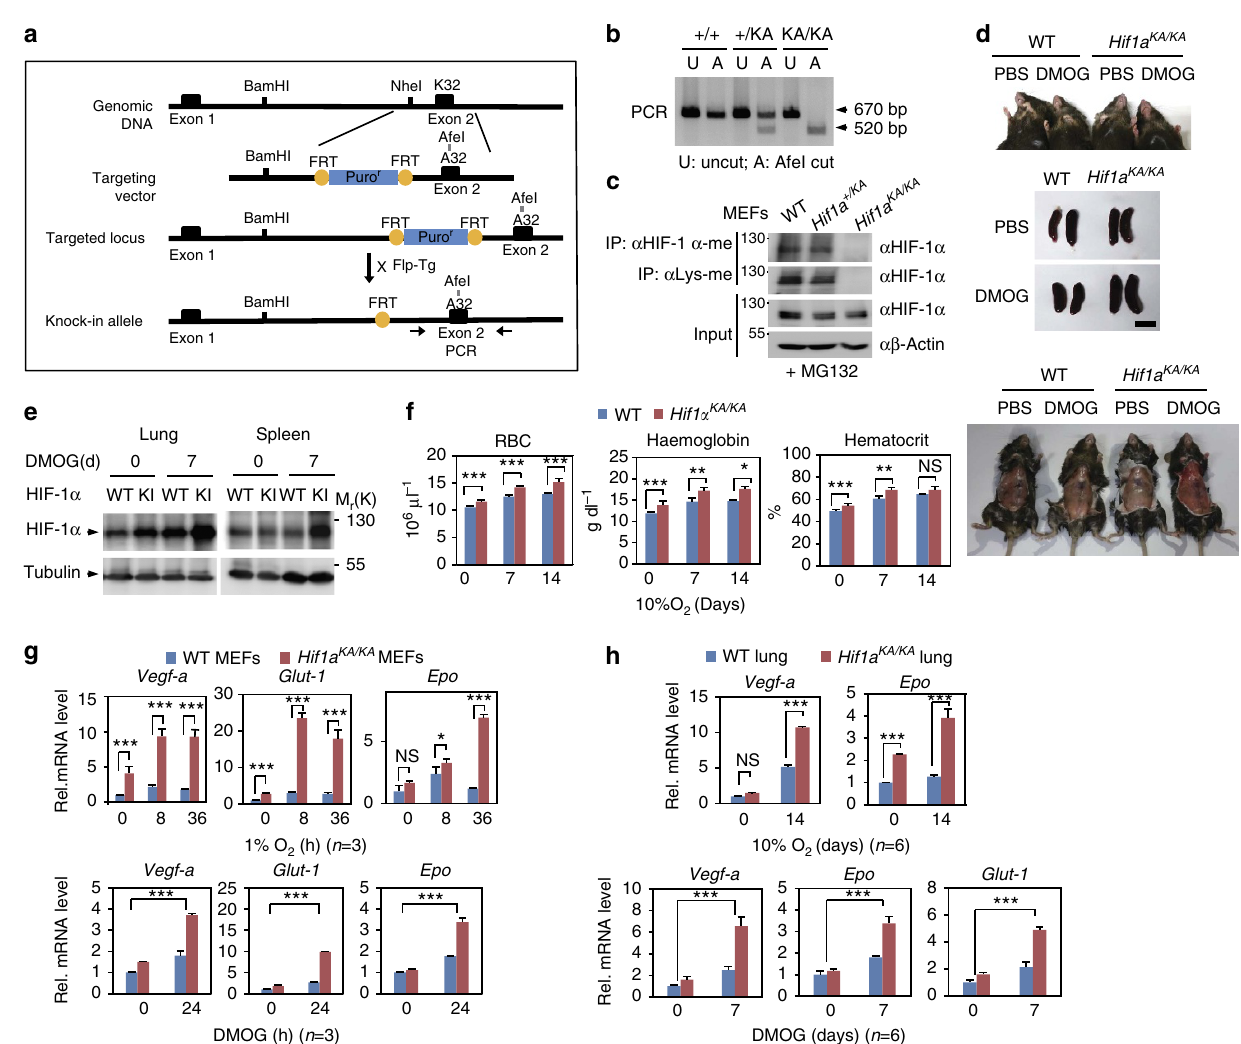
Figure 3 | Hif1a KA/KA knock-in mice show a haematologic abnormality with elevated Epo levels. ( a ) Strategy for the generation of Hif1a KA/KA knock-in mice. Site-directed mutagenesis introduced lysine to alanine substitutions, which generated the AfeI site. ( b ) Genotyping of WT, Hif1a þ /KA and Hif1a KA/KA mice. The Hif1a KA/KA allele but not the WT allele was digested by the AfeI restriction enzyme. A, AfeI cut; U, uncut. ( c ) HIF-1 a methylation levels were assessed in WT, Hif1a þ /KA and Hif1a KA/KA MEFs. ( d ) Phenotypes of WTand Hif1a KA/KA mice treated with DMOG or PBS for 7 days. Upper panel: paws and snouts; middle panel: spleens. Scale bar, 10mm; lower panel: peritonea. ( e ) IB analysis was performed using anti-HIF-1 a antibody to monitor HIF-1 a protein levels in mouse lung and spleen extracts. Mice were treated with DMOG or PBS for 7 days. ( f ) Haematological parameters of peripheral blood from WT and Hif1a KA/KA mice. Hb, haemoglobin; Hct, haematocrit; RBC, red blood cells. Data are expressed as mean ± s.d. (WT mice: n ¼ 7 in normoxic condition, n ¼ 6 in hypoxic condition for 7 days, n ¼ 4 in hypoxic condition for 14 days; Hif1a KA/KA mice: n ¼ 7 in normoxic condition, n ¼ 5 in hypoxic condition for 7 days, n ¼ 4 in hypoxic condition for 14 days, one-way analysis of variance (ANOVA), * P o 0.05, ** P o 0.01, *** P o 0.001). ( g ) mRNA levels of Vegf-a , Glut-1 and Epo in WTand Hif1a KA/KA MEFs were compared at the indicated times of hypoxic conditions (upper panel) or DMOG treatment (lower panel). Data are expressed as mean ± s.d. ( n ¼ 3 for each group, one-way ANOVA or two-way ANOVA, * P o 0.05, ** P o 0.01, *** P o 0.001). ( h ) mRNA levels of Vegf-a and Epo in WT and Hif1a KA/KA mouse lung extracts were compared. Mice were incubated in a hypoxia chamber for 14 days (upper panel) or treated with DMOG for 7 days (lower panel). Data are expressed as mean ± s.d. ( n ¼ 6 for each group, one-way ANOVA or two-way